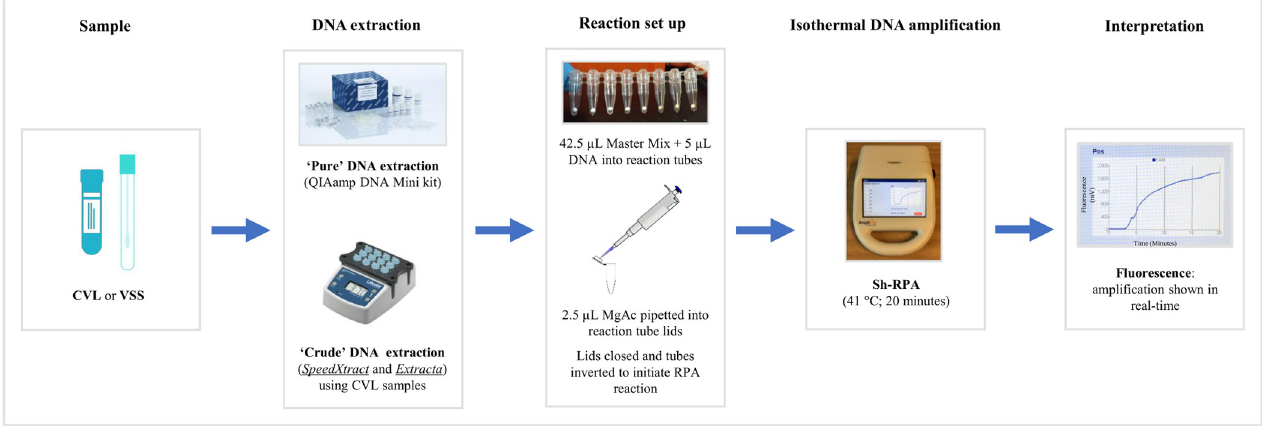
Fig 1. Schematic showing steps involved in Sh-RPA